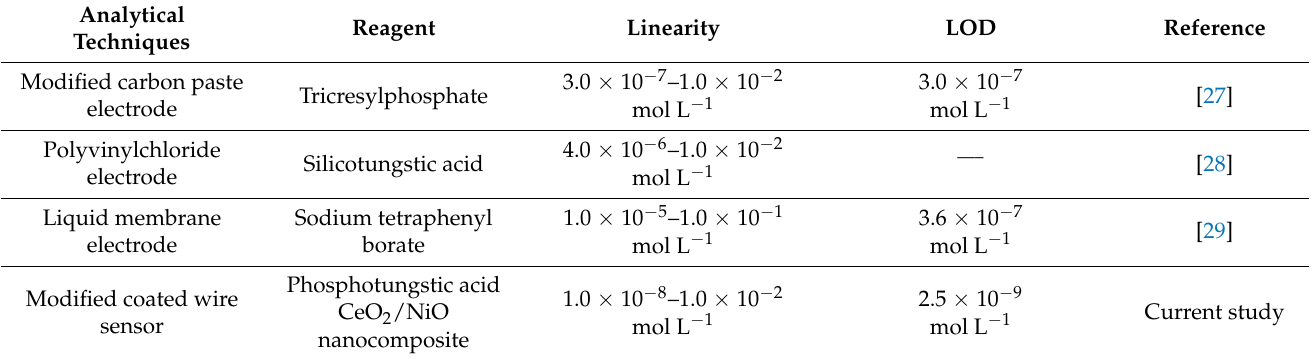
Table 7. A comparative study between the results obtained from the determination of MB MB-PT and MB-PT-CeO 2 /NiO nanocomposite sensors and the previously reported analytical